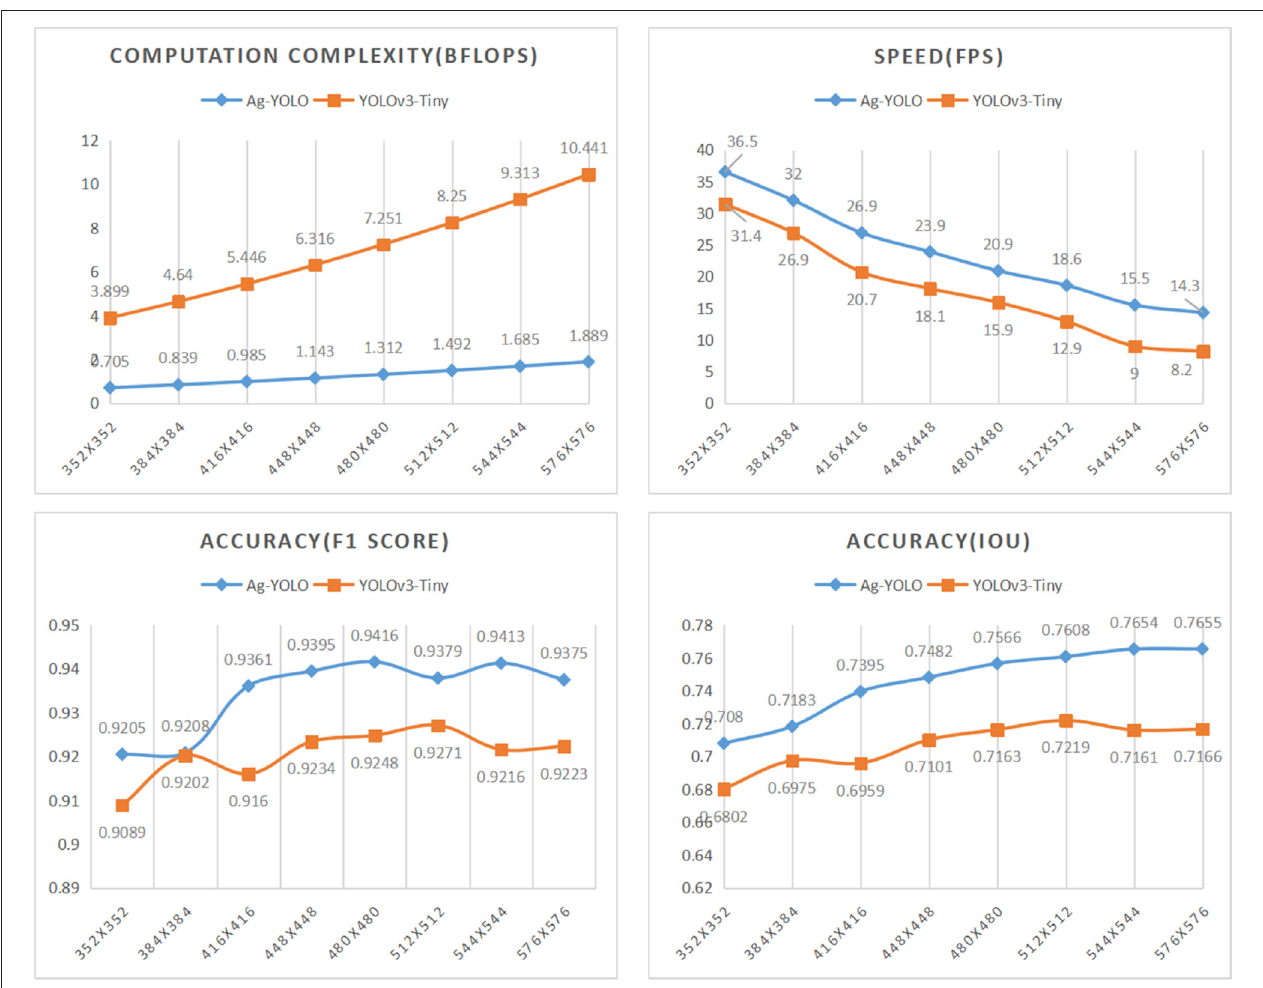
FIGURE 11 | Ag-YOLO vs. YOLOv3-Tiny under different input dimensions.